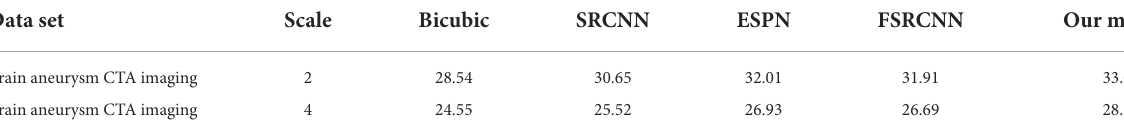
TABLE 2 PSNR experimental data.